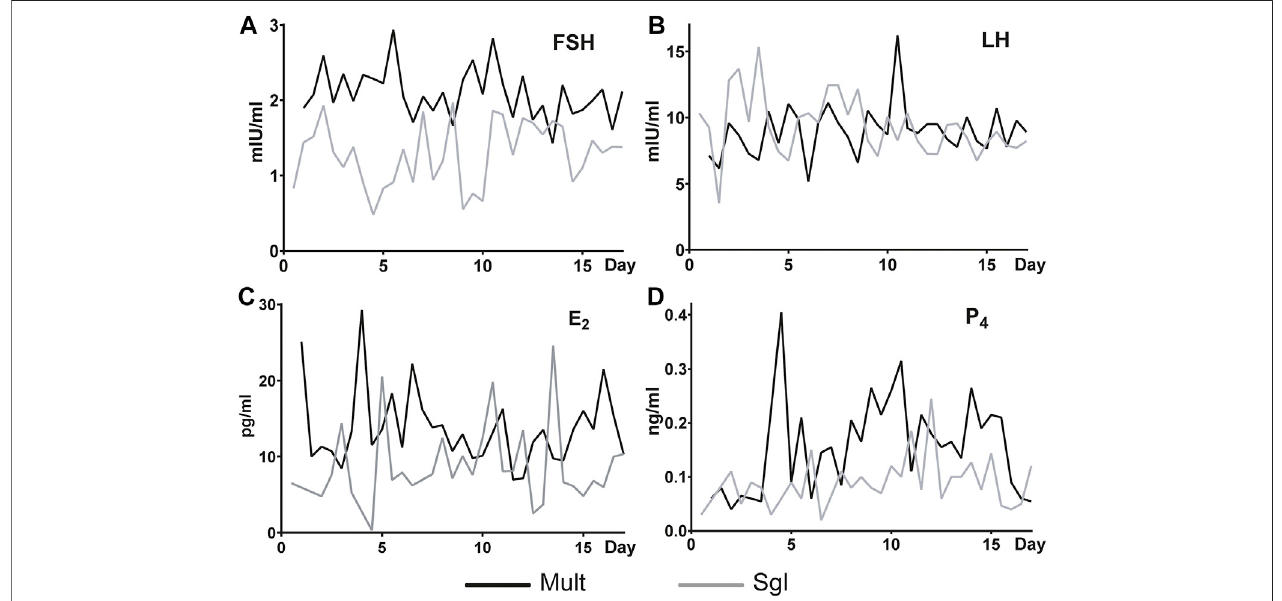
FIGURE 1 | Serum FSH, LH, E2, and P4 levels in Small Tailed Han sheep and Xinji fi ne wool sheep. FSH, follicle-stimulating hormone; LH, luteinizing hormone; E2, estradiol; P4, progesterone. Mult, Small Tail Han sheep group, n (cid:1) 12; Sgl, Xinji fi ne wool sheep group, n (cid:1) 12. The abscissa is thenumber of days sincethe fi rst estrus. Since the fi rst estrus, blood samples were taken twice a day until 17.5 days (the next estrus